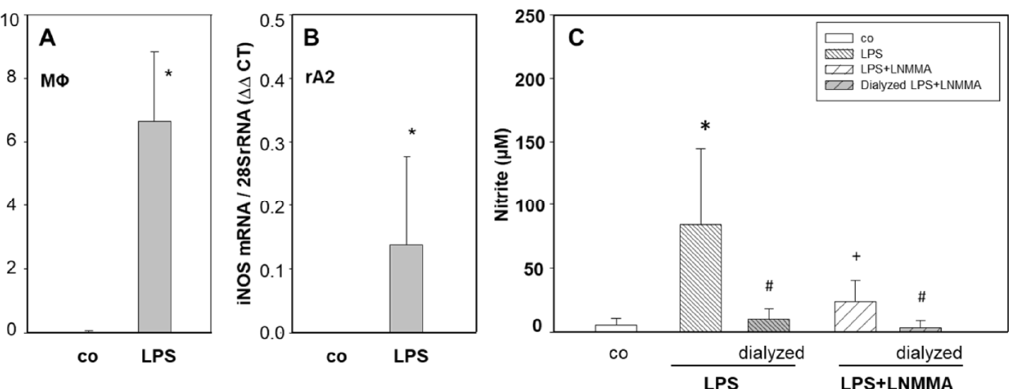
Figure 2. Effect of LPS treatment on the mRNA expression of iNOS in macrophages and rA2 mono- layers and nitrite levels in dialyzed macrophage conditioned media. Macrophage ( A ) and rA2 cells ( B ) were treated with LPS (1 µg/mL) for 24 h. mRNA expression was normalized to 28S-rRNA. Mean values ± SD of 4 to 5 independent cell preparations. Conditioned macrophage media were prepared by exposing mono-cultures of macrophages to LPS (1 µg/mL) and L-NMMA (1 mM) for 24 h ( C ). Five ml of conditioned medium was dialyzed and nitrite production was measured. Mean values ± SD of 3–6 independent preparations. Level of significance was p < 0.05: * effect of LPS treatment, # effect of dialysis, + effect of L-NMMA treatment. M Φ : rat alveolar macrophages; rA2: rat alveolar epithelial cells.